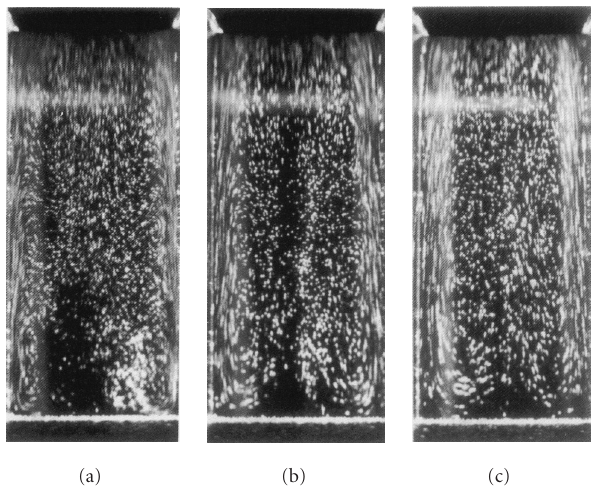
Figure 3: Photograph on meridional plane in drum under spin- down process from 5s/rev to zero: (a) t = 6 seconds, (b) t = 20 seconds, and (c) t = 40 seconds (Ohue et al.